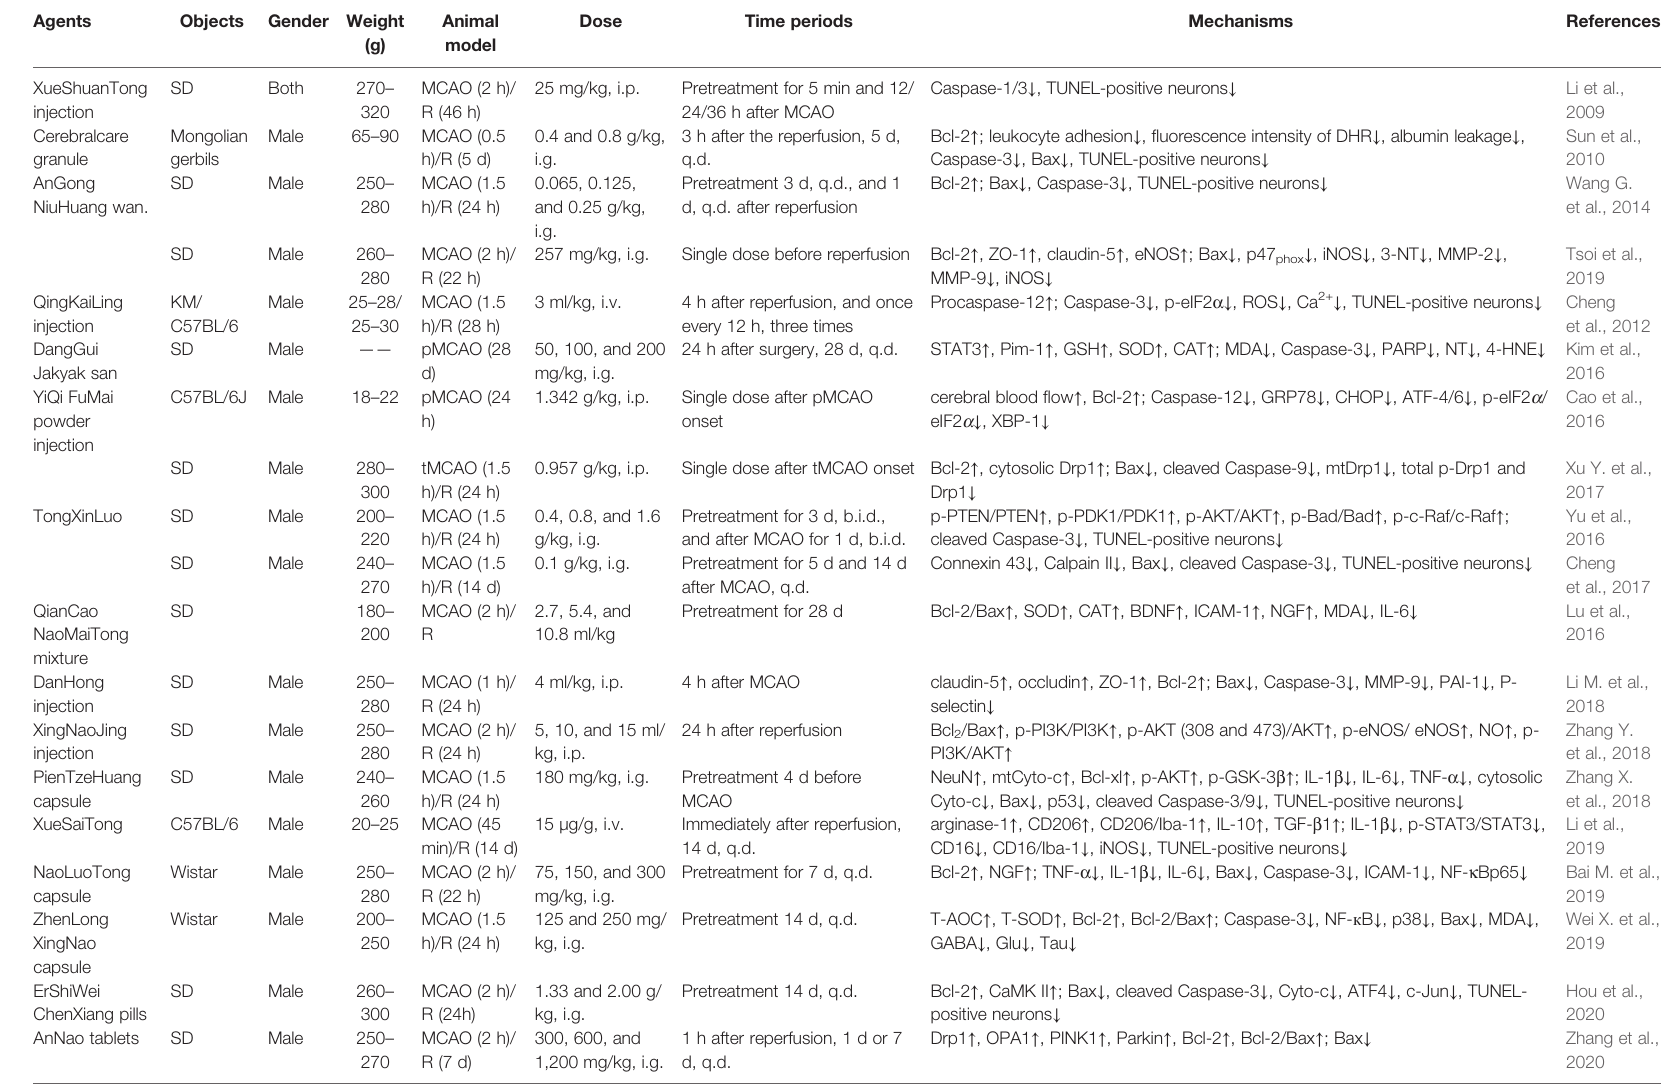
TABLE 1 | The in vivo mechanism underlying the inhibition of MPTP opening-induced neuronal apoptosis by authorized drugs in the treatment of ischemic stroke. Agents Objects Gender Weight